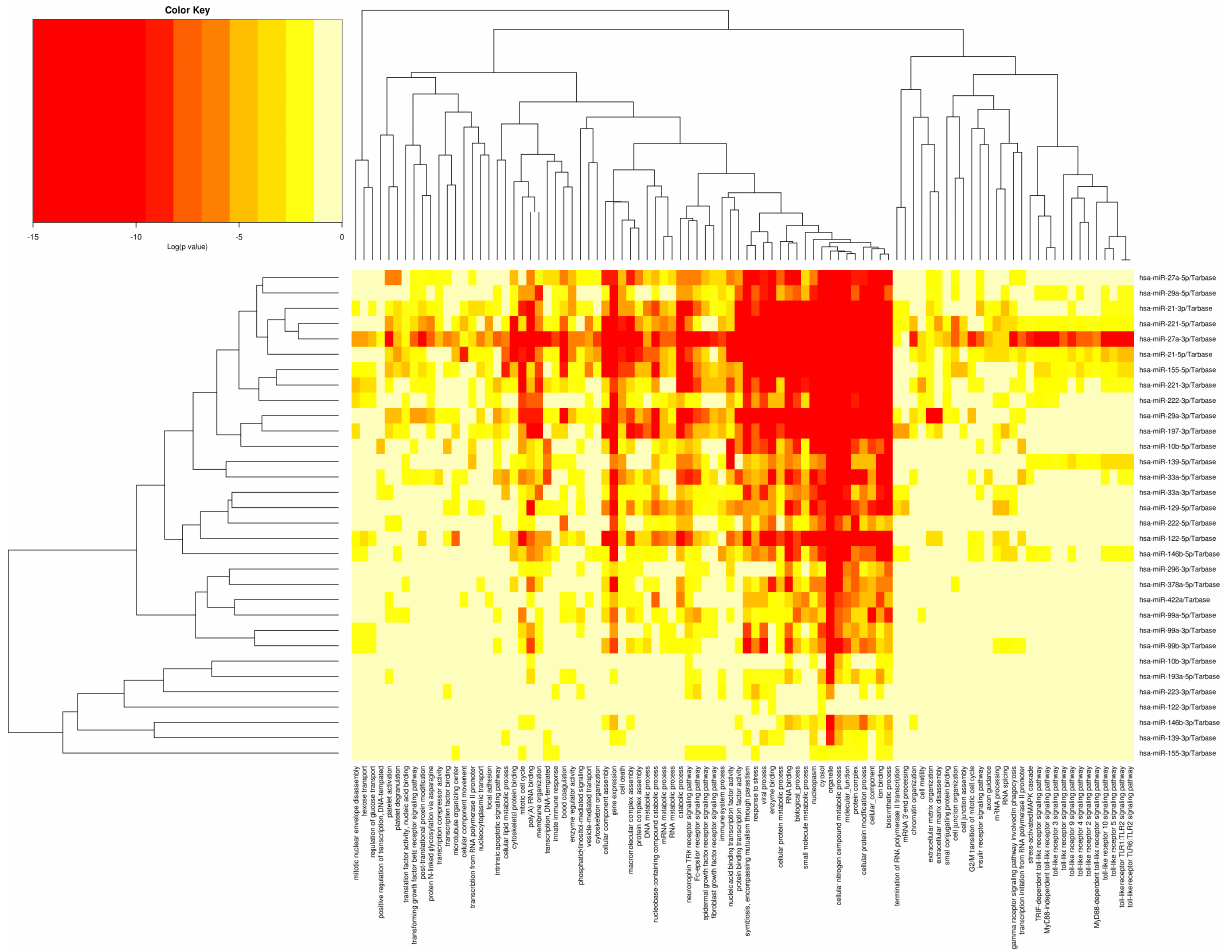
Figure 3. The heatmap associated with gene ontology (GO) analysis of miRNAs.